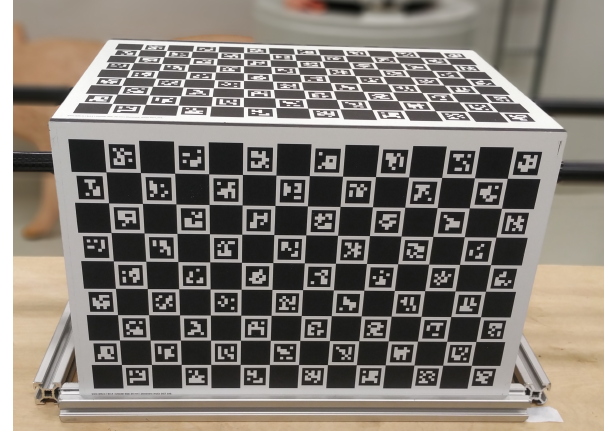
Figure 7. Charuco rectangular cuboid.